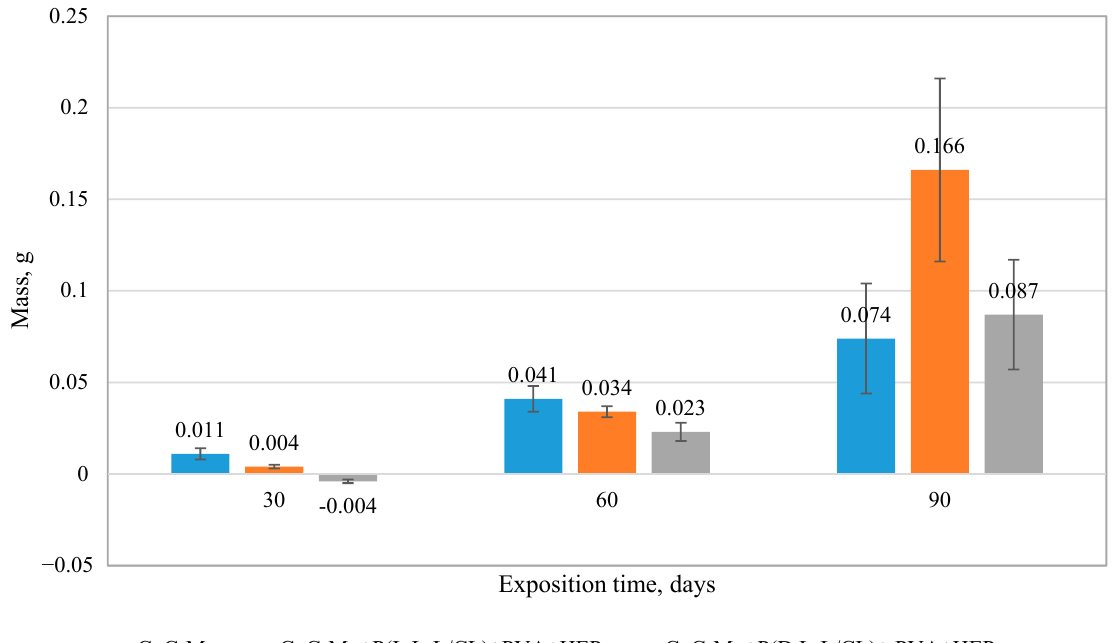
Figure 9. Mass balance of samples (with and without heparin coatings) subjected to 90-day dynamic exposure to artificial urine ( p < 0.05 versus the control group).